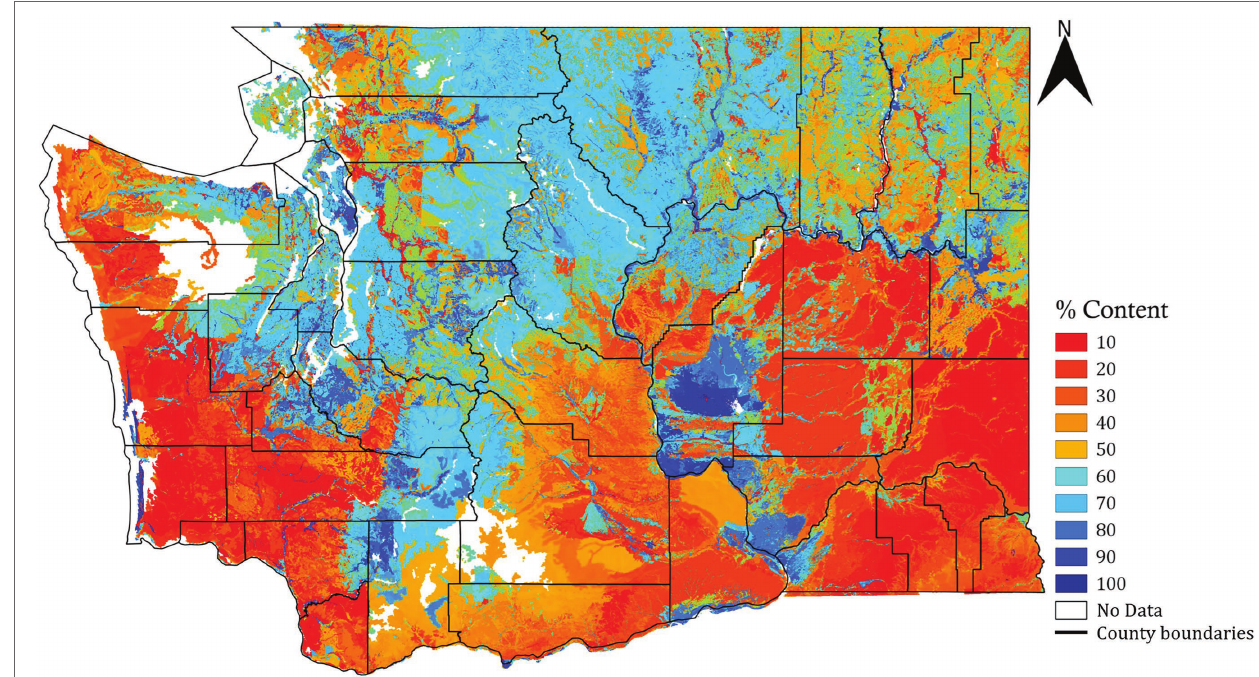
FIGURE 1 | Soil sand content raster map for the state of Washington (depth: 0–100 cm, spatial resolution: 14.5